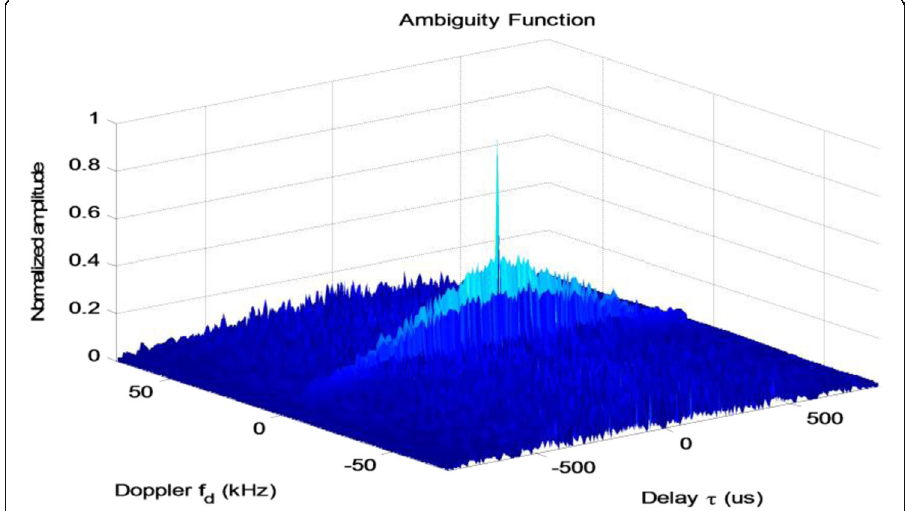
Fig. 8 Doppler tolerance of